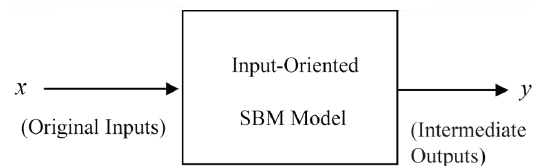
Fig. 2. Schematic diagram of the first-stage input oriented SBM model